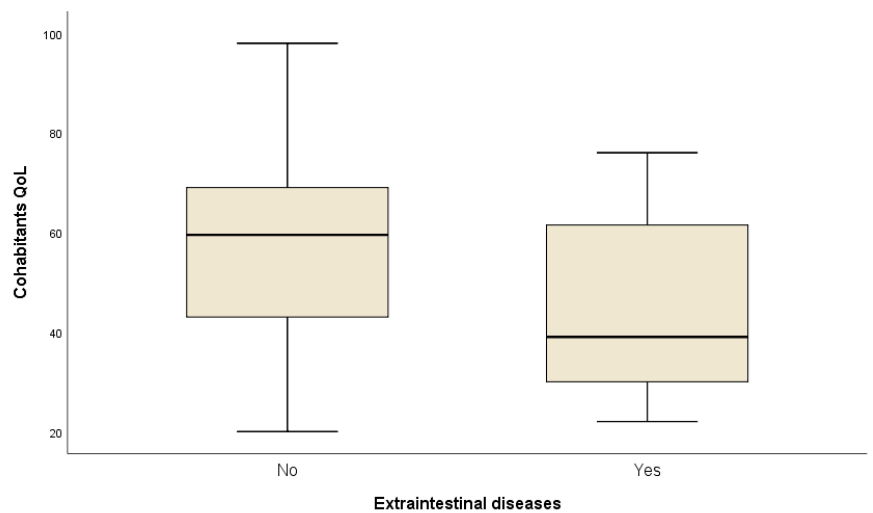
Figure 2. Means comparison of HHMQoL-IBD between cohabitants of patients with and without extraintestinal disease.